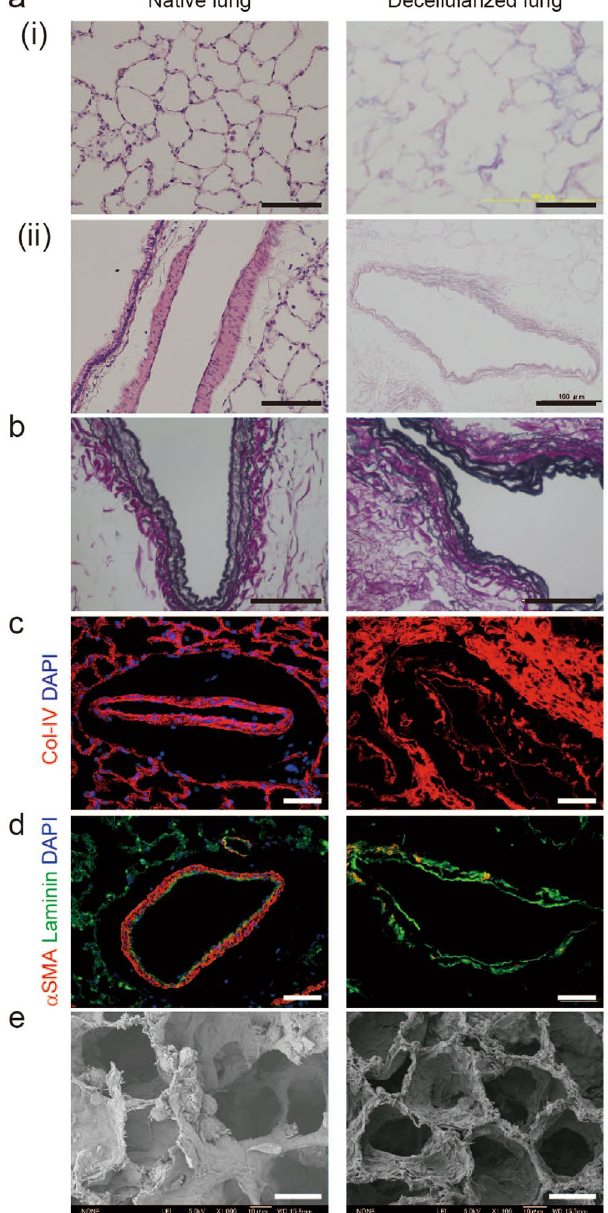
Figure 2. Decellularization of whole rat lungs generates a pulmonary vasculature matrix without a cellular component. Thin sections from native (left panels) and decellularized (right panels) rat lungs: ( a ) hematoxylin and eosin ( H&E) staining showing no remaining nuclei or intracellular components in the decellularized lung parenchyma (i) or pulmonary vasculature (ii); ( b ) Elastica van Gieson staining showing pulmonary vasculature elastic fibers in the decellularized lungs; ( c, d ) Fluorescence micrographs showing preservation of the pulmonary vasculature matrix after decellularization comprising ( c ) collagen IV (red) and ( d ) laminin (green), with no remaining cellular components ( c, d : DAPI, blue) or α -smooth muscle actin ( d : red); ( e ) scanning electron microscopy images showing preservation of the 3D decellularized matrix scaffold structure. Scale bars: 100 μ m ( a–d ); 20 μ m ( e